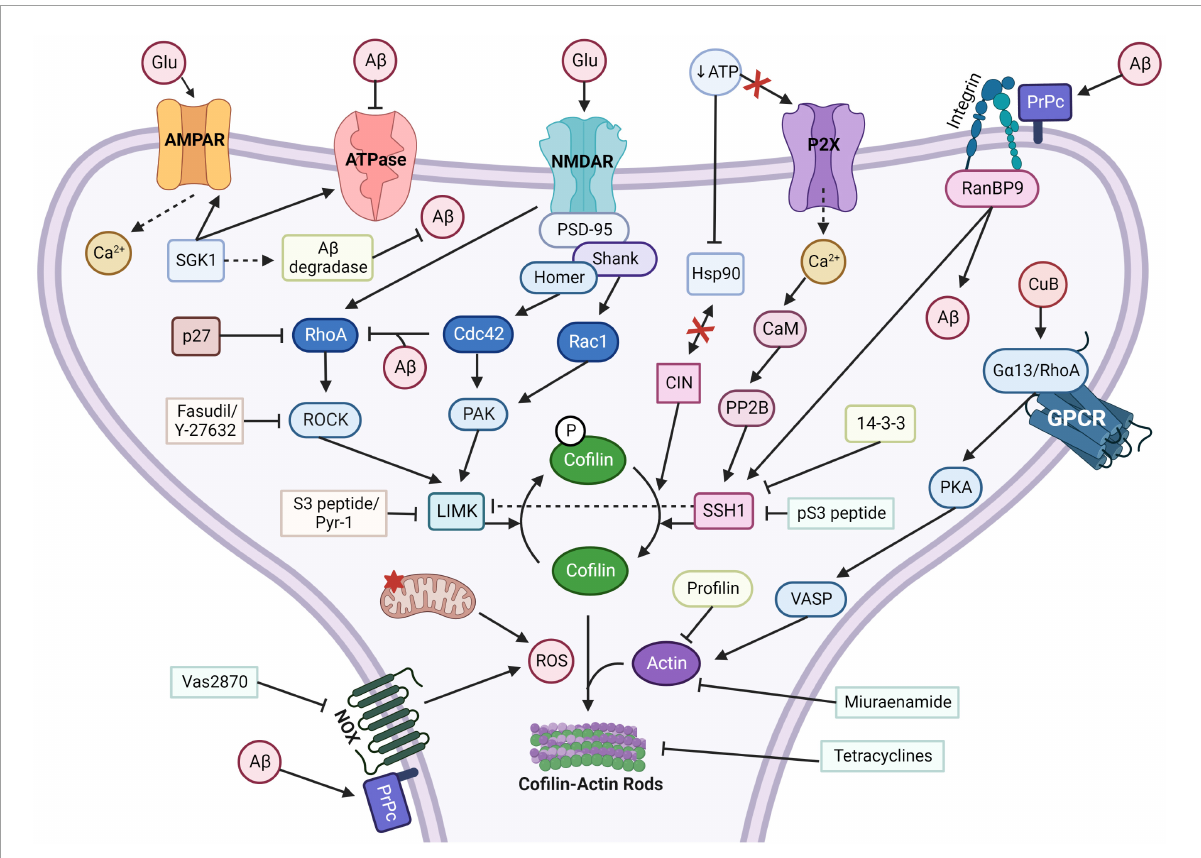
FIGURE3 Cofilin-actin rod forming pathways with activators and inhibitors. Cofilin-actin rods can be induced through multiple separate pathways. Calcineurin (PP2B) or RanBP9 stimulation of SSH1 or chronophin (CIN) dephosphorylates and activates cofilin, which under stress can form aberrant rods with actin. Inhibitors of SSH1, such as 14-3-3 and pS3 peptide, can prevent rod formation. Miuraenamide and profilin overexpression can prevent actin from associating with cofilin, and tetracycline can disrupt rods. A β induction of integrin/RanBP9 or NOX with PrPc promotes rod formation, but Vas2870 can inhibit NOX generation of ROS. CuB activates the G α 13/RhoA/VASP pathway and increases actin assembly. LIMK, activated by PAK and RhoA/ROCK, phosphorylates and inactivates cofilin. Inhibitors of LIMK, such as the S3 peptide or Pyr-1, can promote cofilin-actin rod formation. Created with